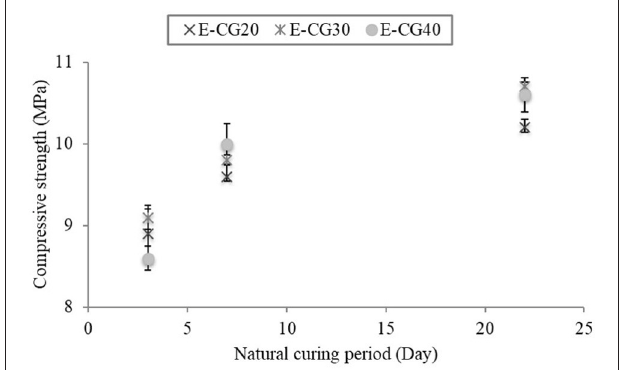
FIGURE 1 | Change of theoretical compressive strength.